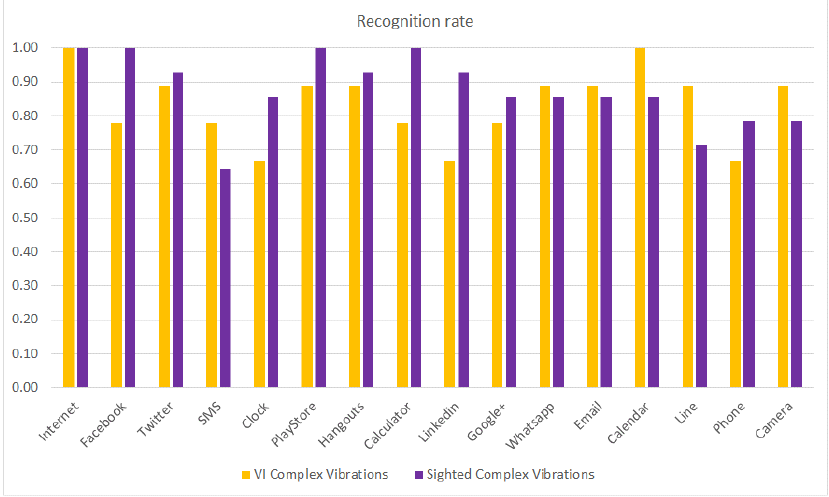
Figure 9. Recognition rate per haptic icon for VI and sighted people using complex vibration pat-